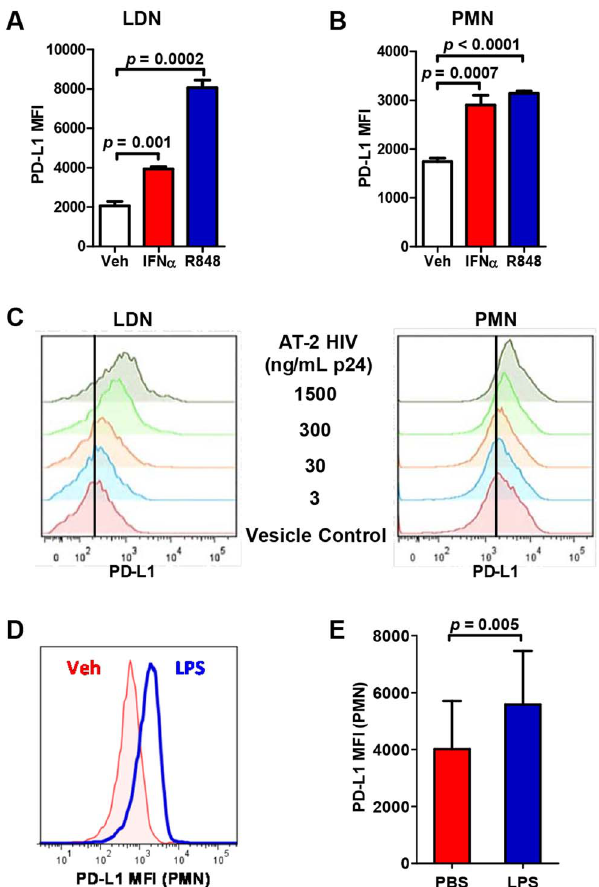
Figure 3. PD-L1 expression on neutrophils is induced by HIV-1 virions, IFN a , TLR-7 ligand R848, and LPS. A, B) PBMCs or PMNs were stimulated with IFN a (1,000 U/ml), R848 (5 m g/ml), or vehicle (Veh) for 24 hours and PD-L1 expression on CD15 + LDNs and PMNs was